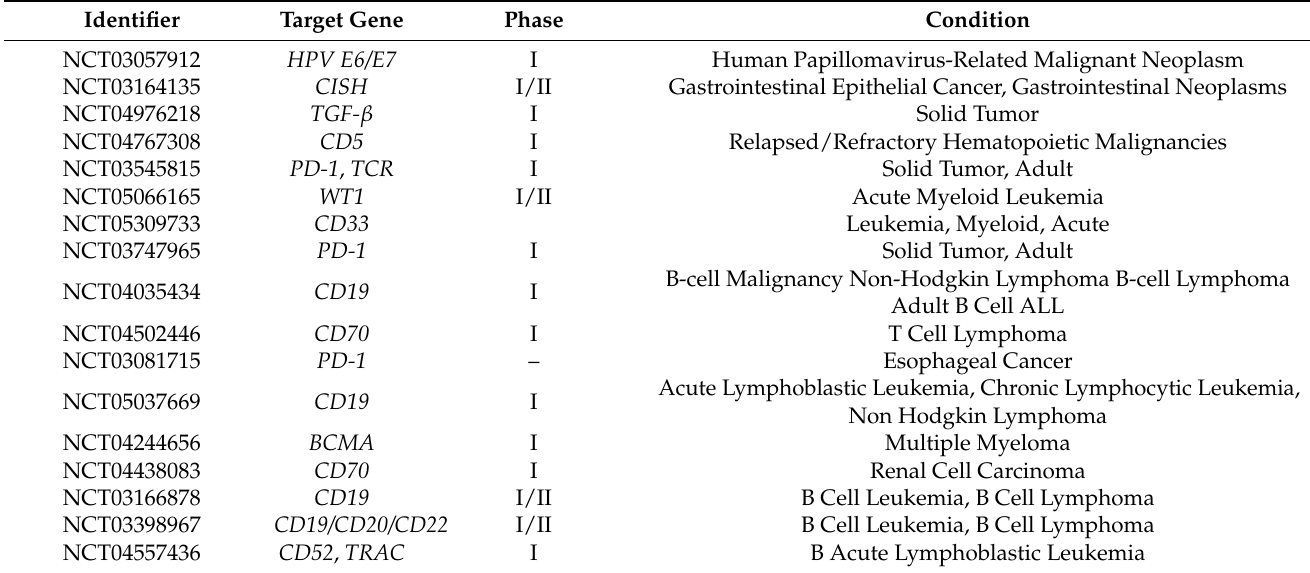
Table 2. Clinical trials of the CRISPR/Cas system for cancer therapy.